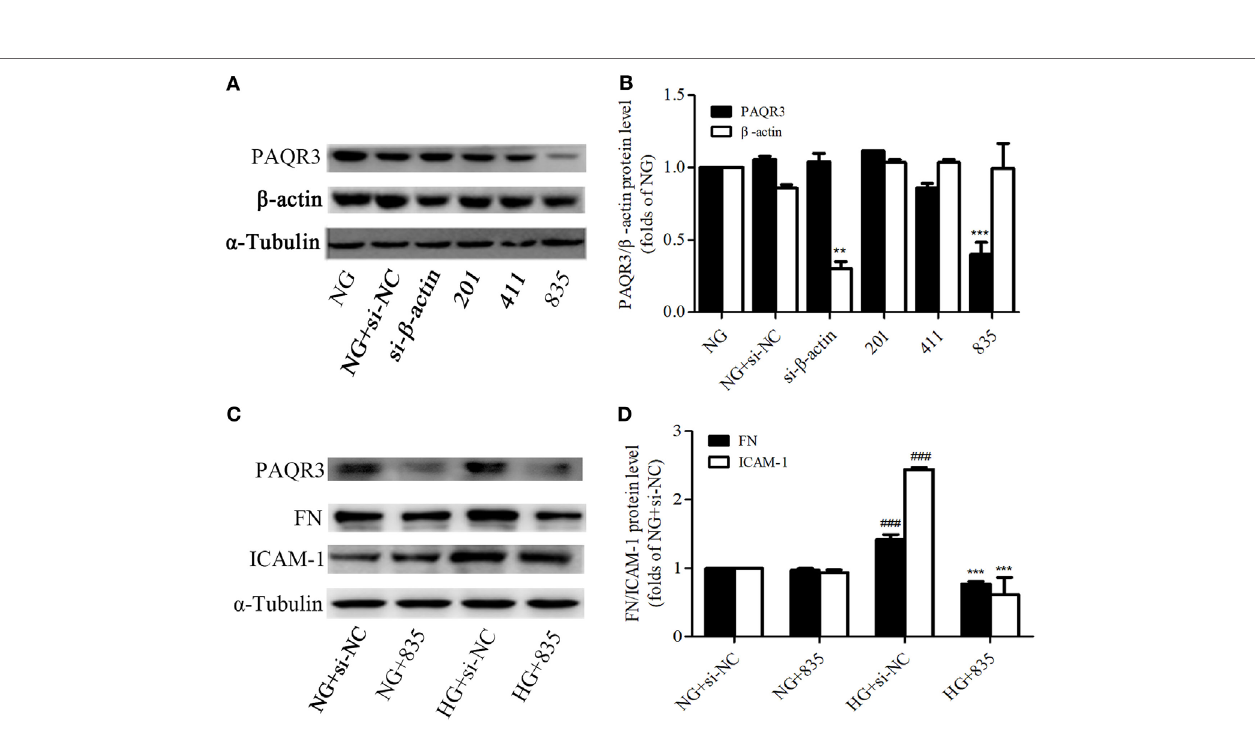
FigUre 3 | Progestin and adipoQ receptor 3 (PAQR3) depletion reduced the high glucose (HG)-induced fibronectin (FN) and intercellular adhesion molecule-1 (ICAM-1) expressions. Glomerular mesangial cells were transfected with negative control and three pairs of siRNA oligonucleotides targeting PAQR3 for 72 h, and then total proteins were harvested and subjected to Western blot assay. NC is a short form of negative control, and the depletion of β -actin protein acts as a positive control, which is used to evaluate the efficiency of PAQR3 depletion (a,B) . ** P < 0.01 vs. NG, *** P < 0.001 vs. NG. PAQR3 depletion inhibited the upregulation of FN and ICAM-1 under HG conditions (c,D) . ### P < 0.001 vs. NG + si-NC, *** P < 0.001 vs. HG + si-NC. Independent experiments were performed at least three times with similar